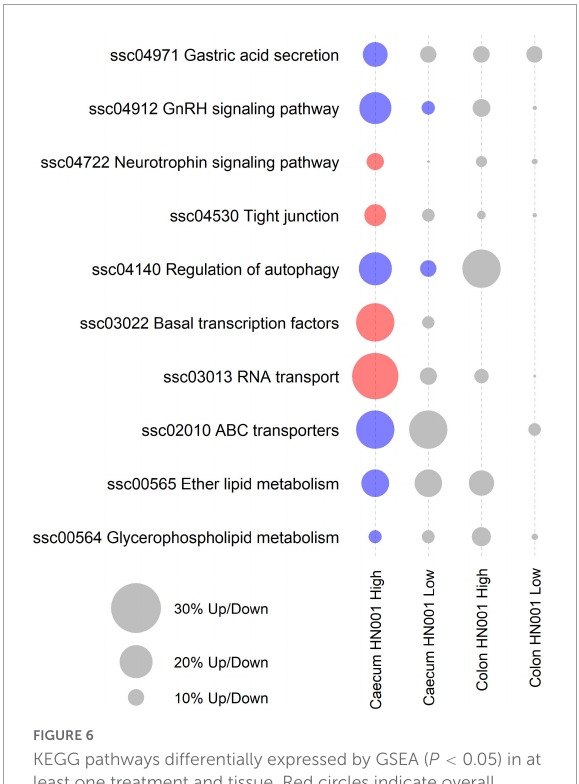
FIGURE6 KEGG pathways differentially expressed by GSEA ( P < 0.05) in at least one treatment and tissue. Red circles indicate overall significantly higher expression compared to Controls and blue circles indicate overall significantly lower expression compared to Controls. Gray circles indicate pathway not differentially expressed ( P > 0.05). Size of circle proportional to the number of genes up or down